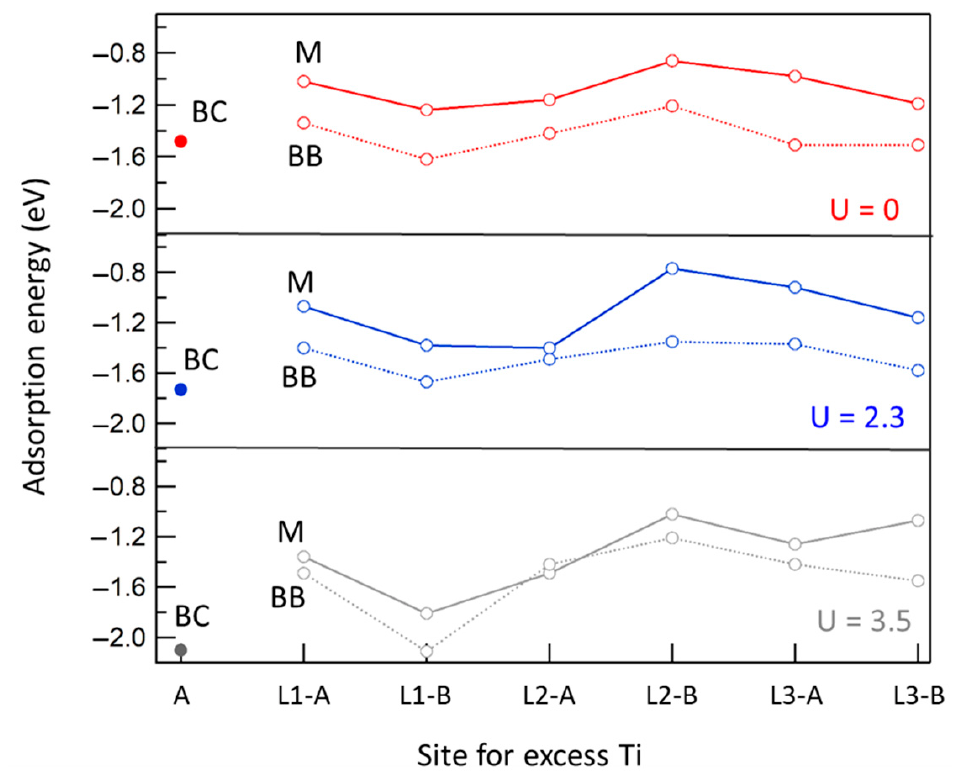
Figure 3. Adsorption energy at the TiO 2 (110) surface for formic acid in the monodentate form (M, solid line) and in the bridging bidentate form (BB, dotted line) as a function of the site for an excess TI atom (see text). BC indicates a formate chelating species. U values in eV.